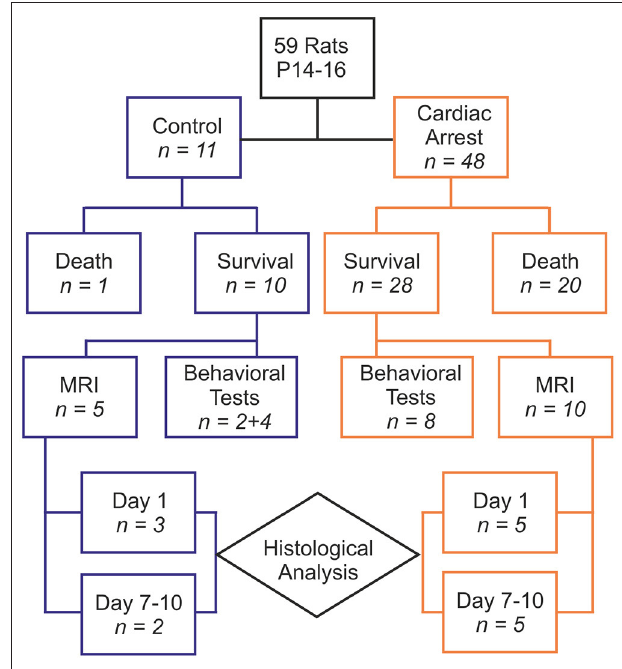
FIGURE 1 | Diagram showing the experimental paradigm of the study with the group distributions and numbers of animals designated to each test